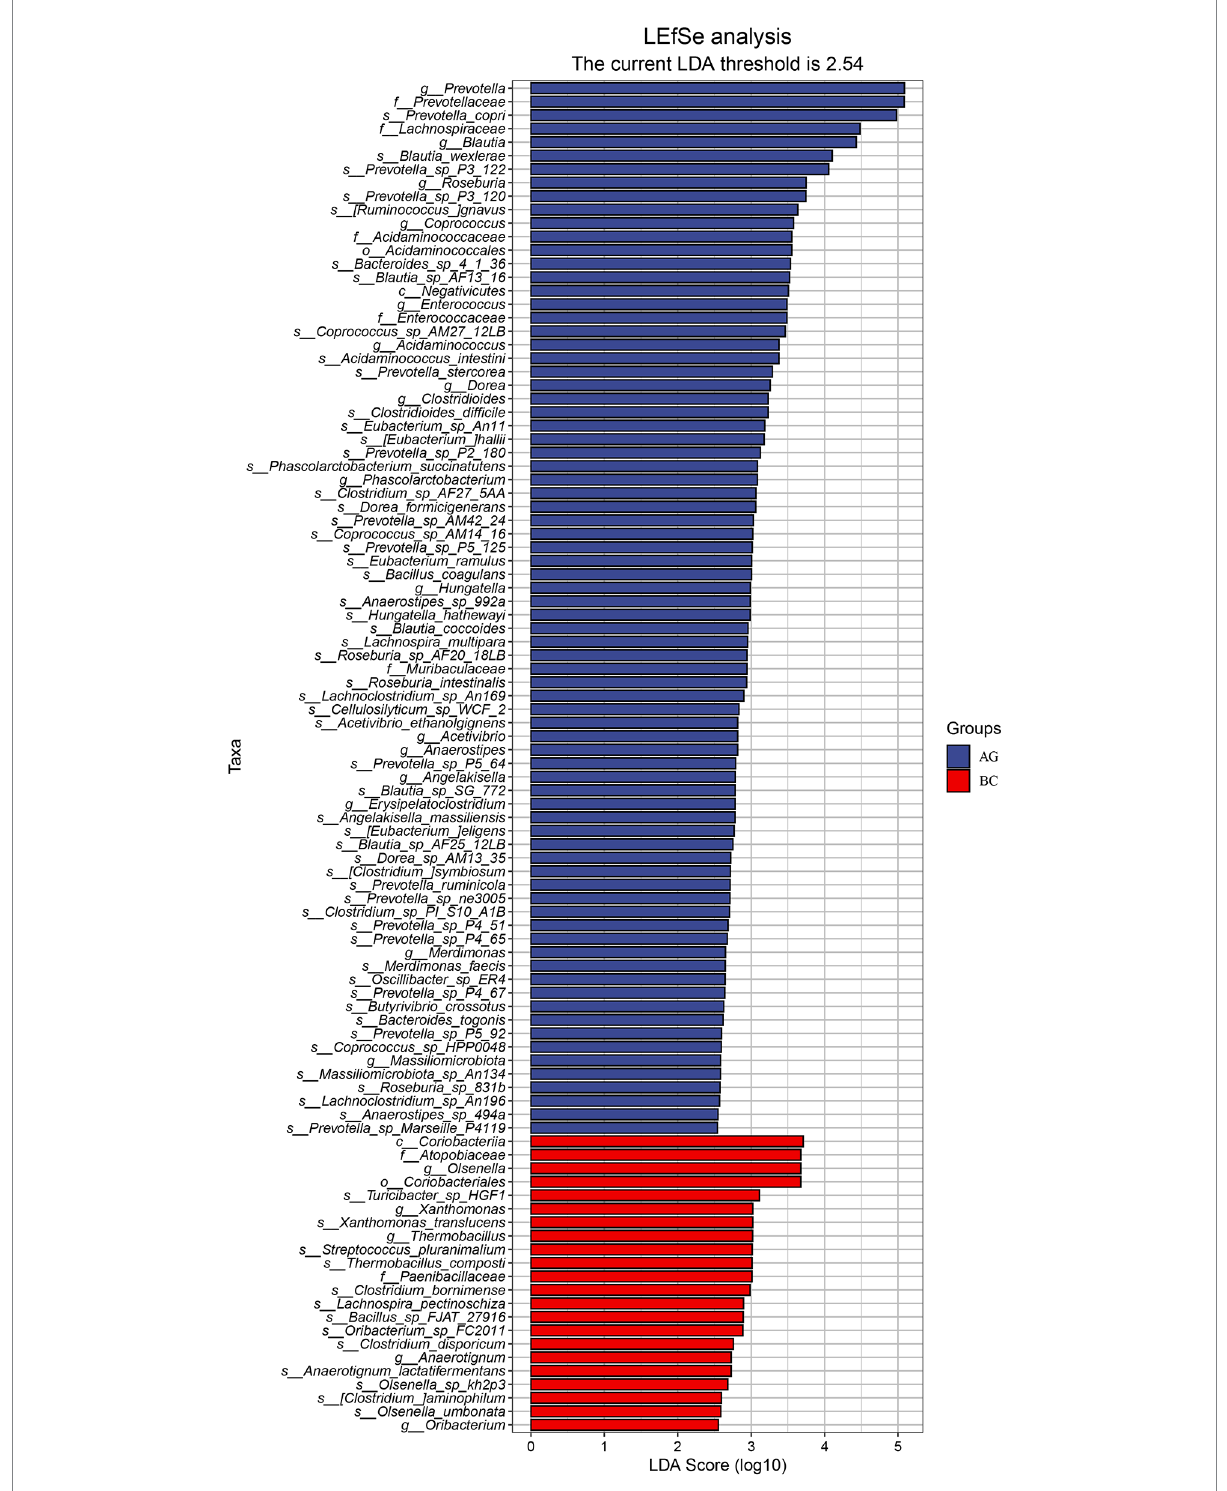
FIGURE 4 LEfSe analysis in the gut microbiota between Xinjiang brown cattle (BC) and Angus cattle (AG). ( n = 5 in each breed). LEfSe, Linear discriminant analysis Effect